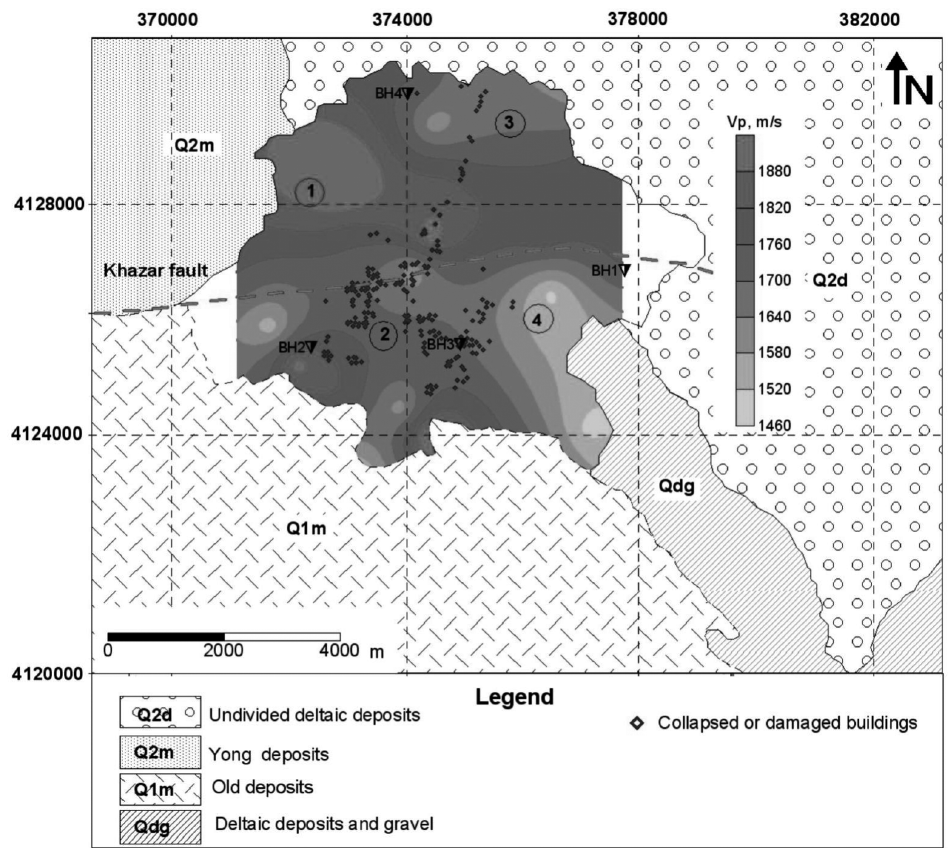
Fig. 7. Variation of Vp in Rasht city underneath of the water